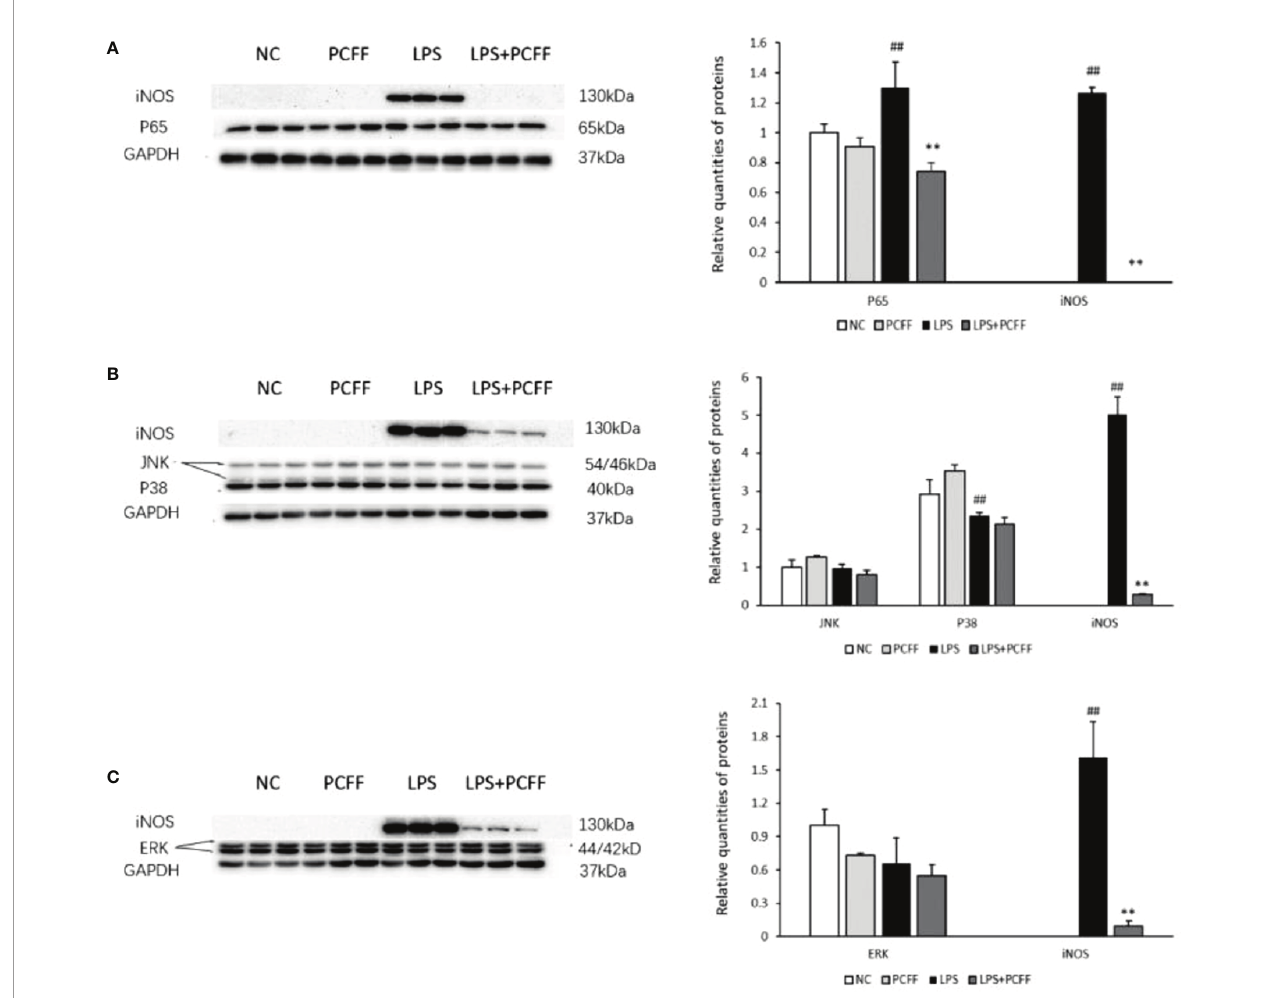
FIGURE 8 | Effects of PCFF on NF- k B and MAPK signaling pathway proteins in LPS-stimulated RAW264.7 macrophages. (A) Effect of PCFF on p65 and iNOS proteins; (B) Effect of PCFF on JNK, P38 and iNOS proteins; (C) Effect of PCFF on ERK1/2 and iNOS proteins. Each value indicates the mean ± SD from three independent experiments. Compared with NC group, ## P < 0.01; compared with LPS group, **P <